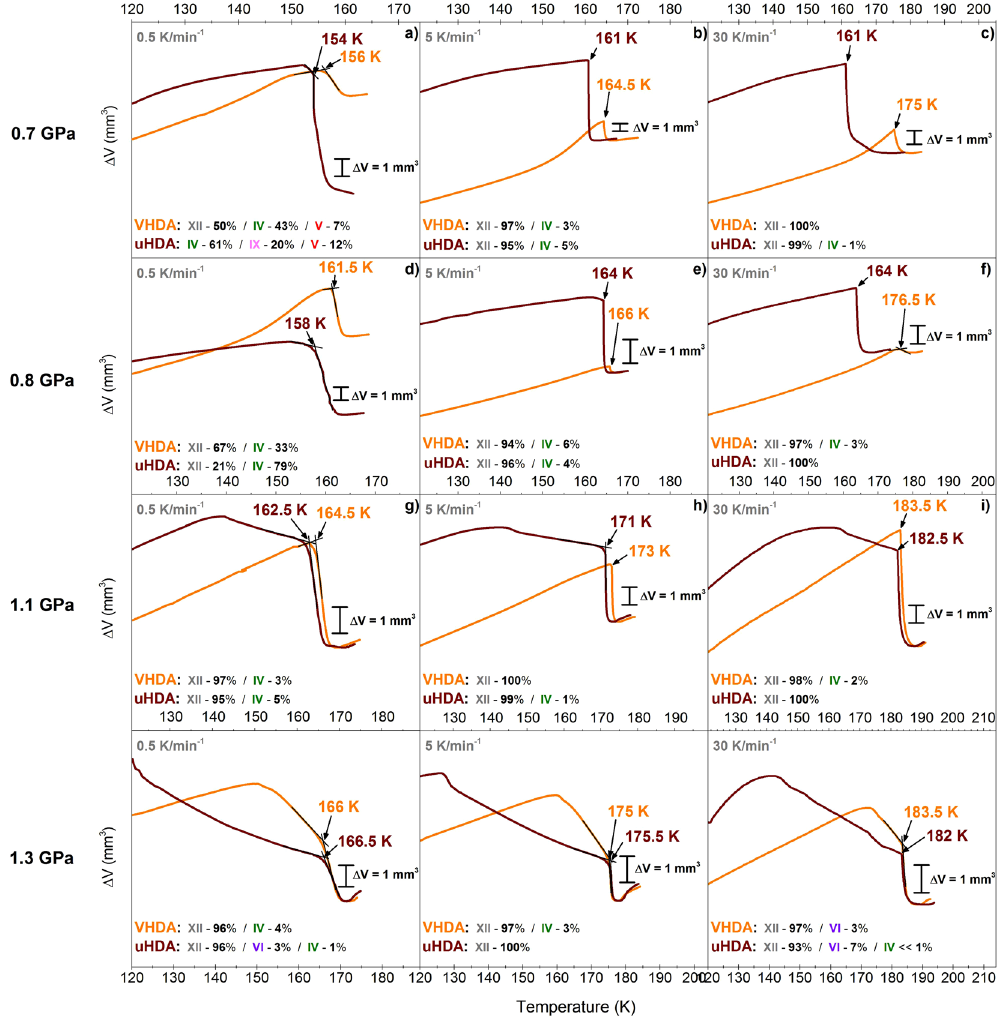
Figure 3. Volume curves of isobaric heating experiments with different heating rates (0.5, 5 and 30 K min − 1 ) for uHDA (brown) and VHDA (orange) at pressures between 0.7 and 1.3 GPa. Crystallisation temperatures T x were identified by rather steep steps in the volume curve indicating transformation to denser crystalline phase mixtures and are labelled with the respective temperature values. Relative yields of crystalline ices in the phase mixtures are indicated by percentages and the various polymorphs coded in different colours (ice IX in pink, ice V in red, ice IV in green and ice XII in